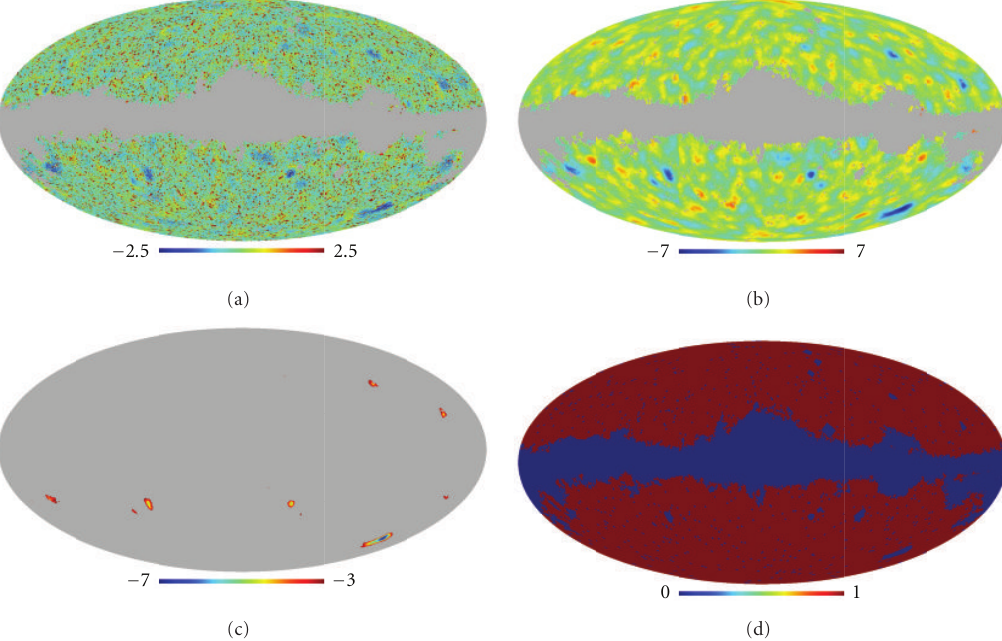
Figure 9: The pixel-wise deviations S i , r of the primal (a) and of the smoothed scaling indices map (b), both based on the VW-band (WMAP 5-year) and the scale parameter r = 0 . 2. The plot in the lower left only shows the values ≤− 3 . 0 of the smoothed method. Except for the very small spots in the right part of this mapping, these regions are added to the KQ75-mask. The result is illustrated in the lower right plot.